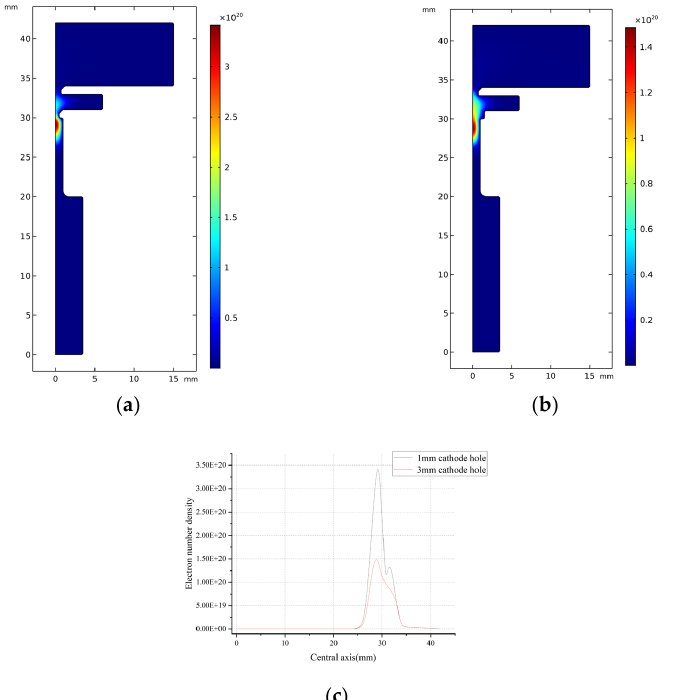
Figure 9. ( a ) Contours of atom number density distribution of C12A7 hollow cathode with cathode orifice 1 mm. ( b ) Contours of atom number density distribution of C12A7 hollow cathode with cathode orifice 3 mm. ( c ) Atom density variation on the symmetry axis along the Z-direction.